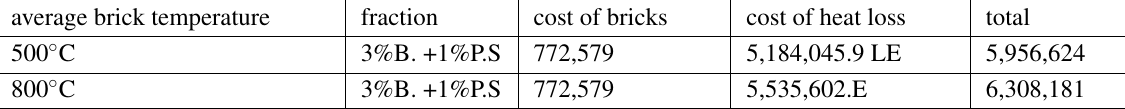
Table 10. Total annual cost associated with a brick wall lined with IFB 88.55 Ton ( ρ B = 1.06 g/cm 3 ) in